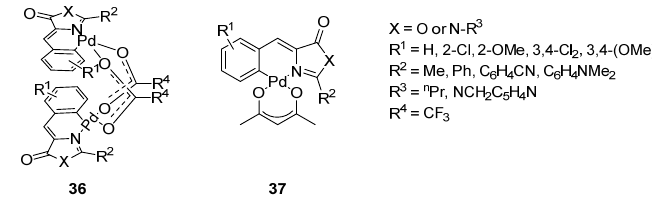
Figure 33. GFPc analogues locked with palladium [50].